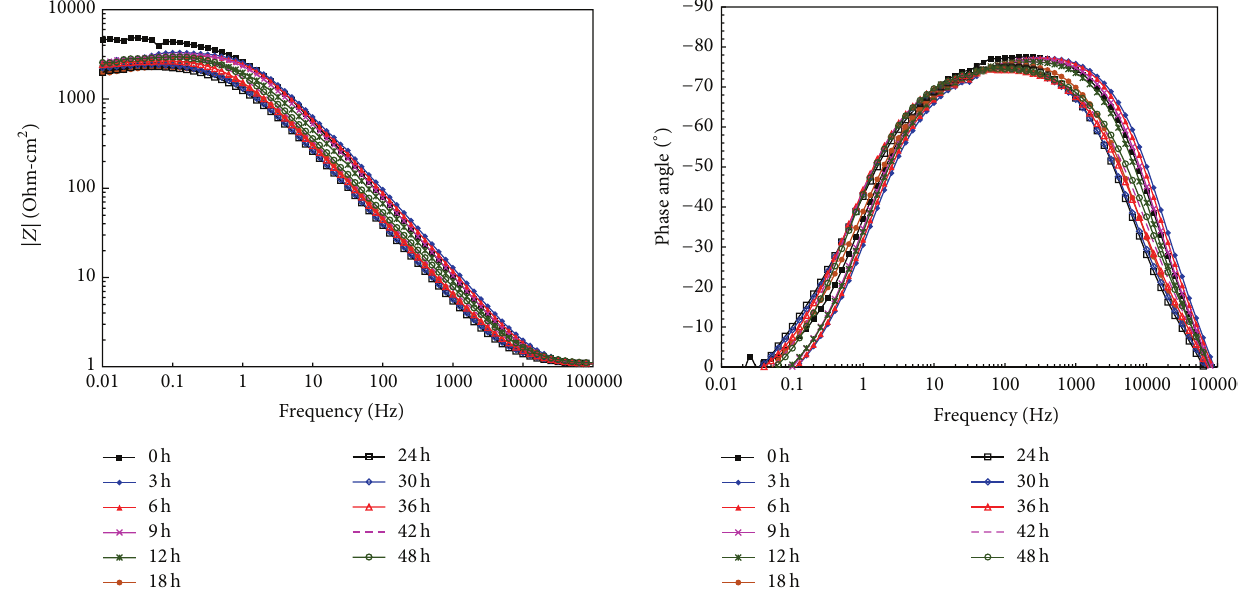
Figure 11: Bode plots for Ni 3 Al-5Cu in 1.0M H 2 SO 4 solution at 25 ∘ C.